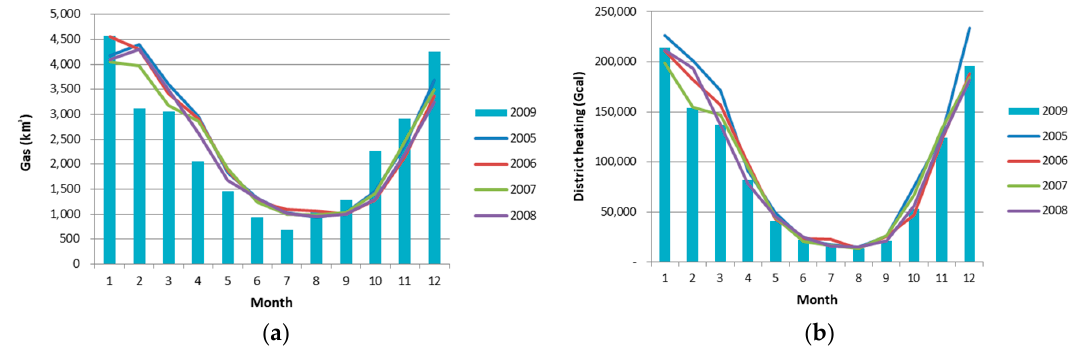
Figure 3. Monthly change: ( a ) gas demand; ( b ) district heating demand.